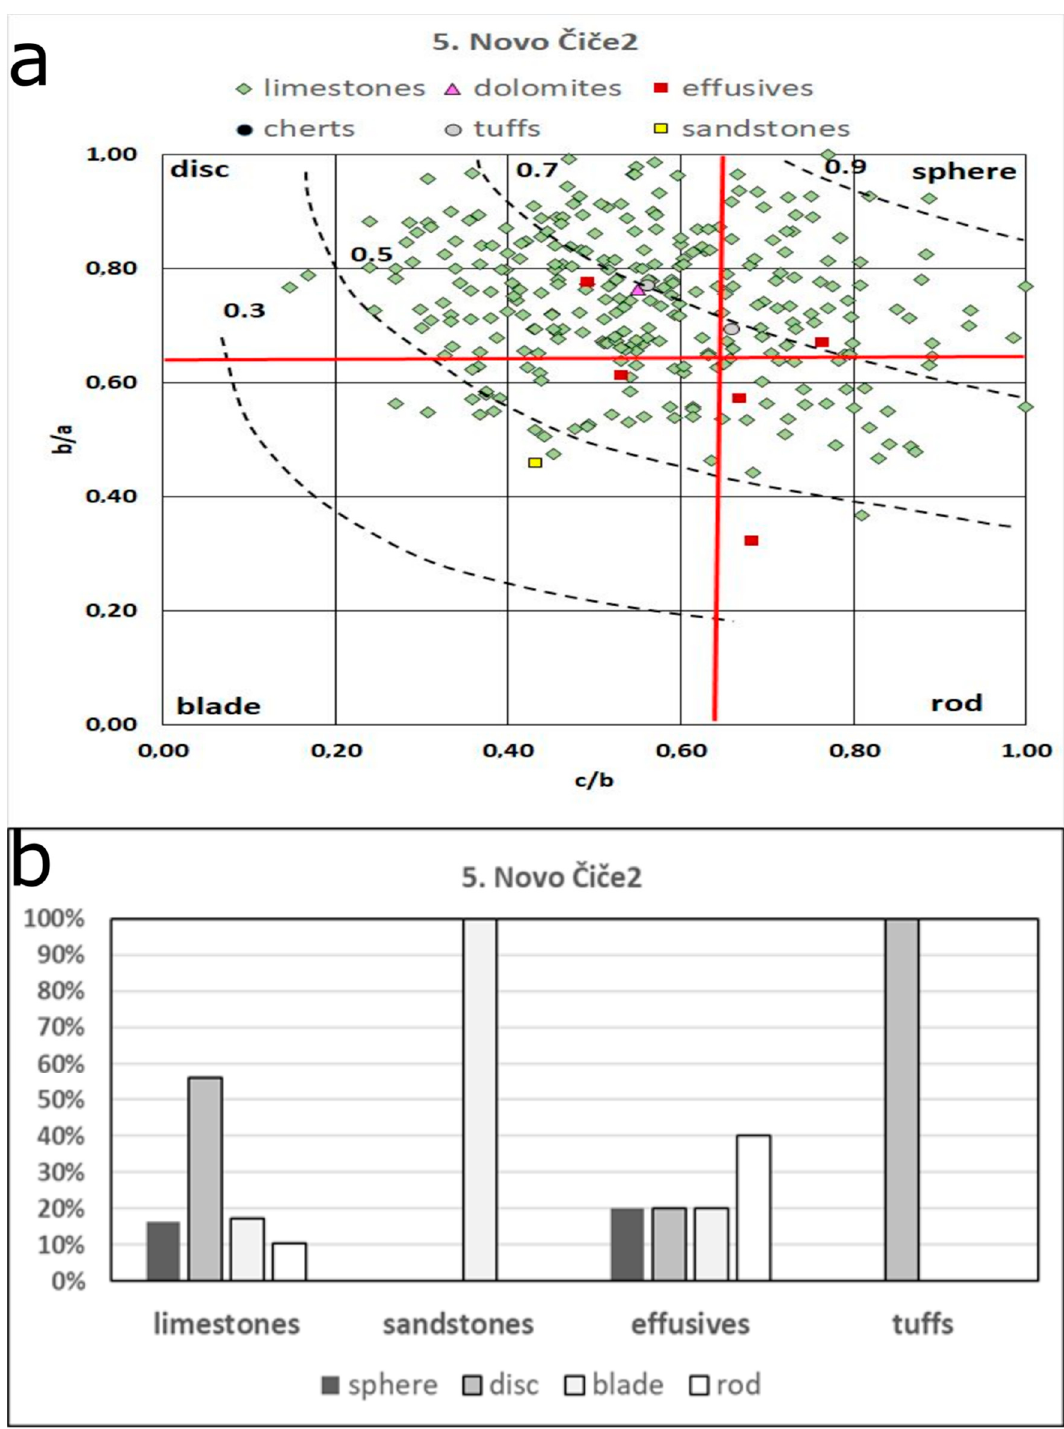
Figure 11. Pebble shapes of main lithotypes in Novo Č i č e 2: ( a ) Zingg diagram; ( b ) histograms. Downstream towards the east, in Novi Petruševec 1, limestone pebbles slightly decrease, retaining mainly disc shapes (Figure 12). All other lithotypes increase, showing scattered distributions in pebble shape.